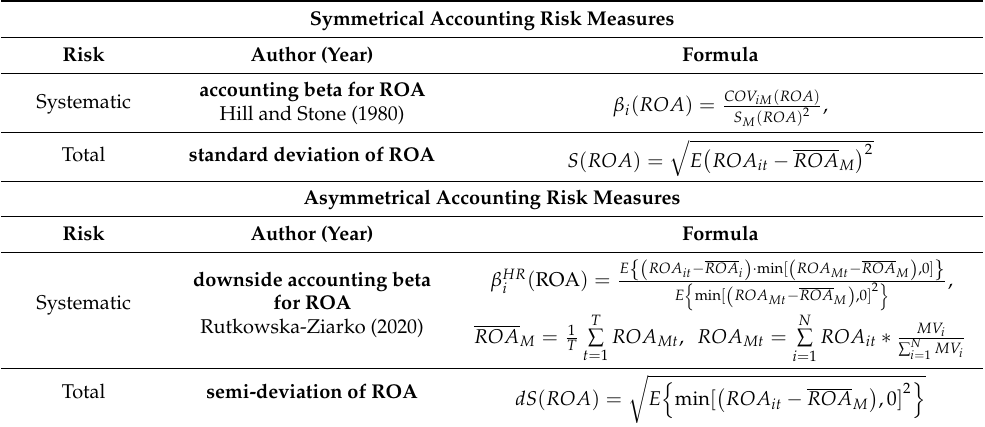
Table 2. Selected accounting risk measures in symmetrical (variance) and asymmetrical